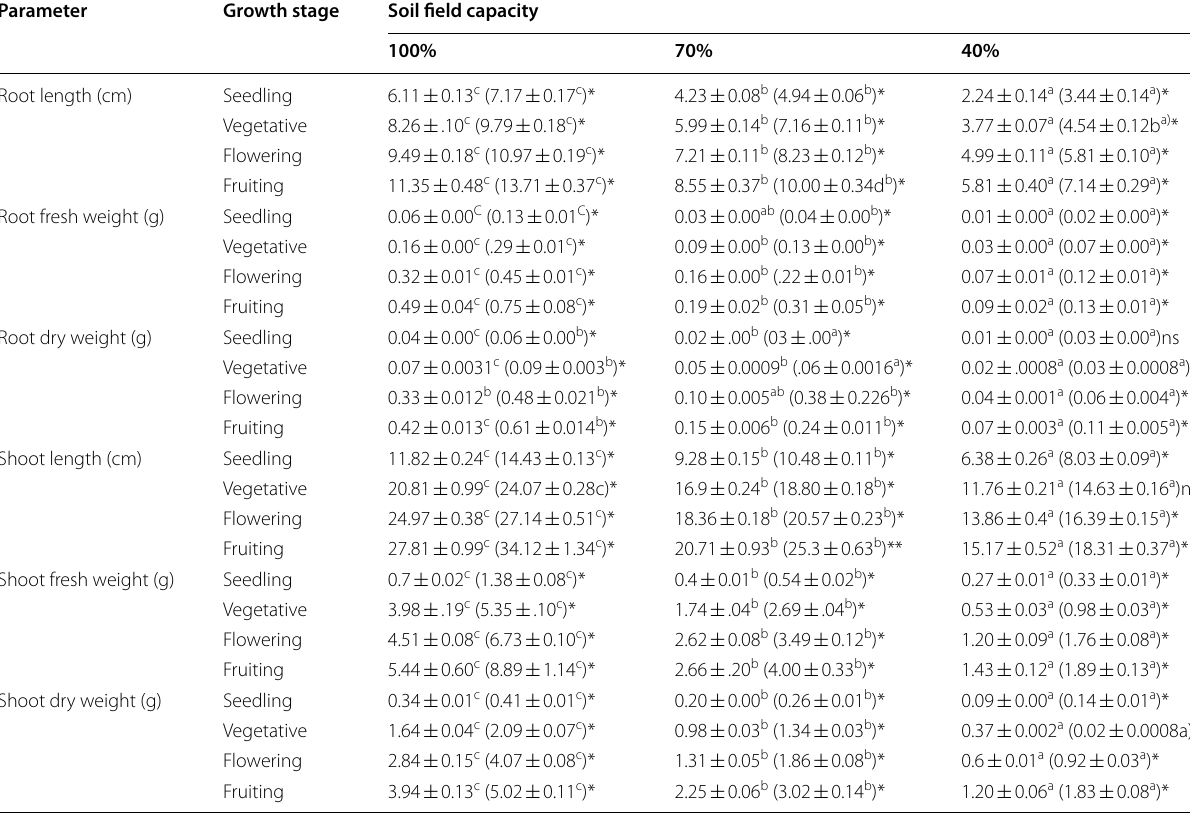
Values of parameters in parentheses correspond to the application of mycorrhiza. Values in a row with different superscript letters are significantly different at P < 0.05. *Significant effect of mycorrhiza application at each soil field capacity at P < 0.05 according to t ‑test. ns : non‑significant effect of mycorrhiza application at each soil field capacity at P < 0.05 according to t-